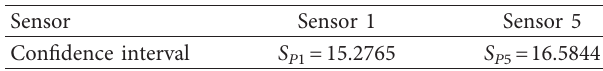
Table 6: The confidence interval of two sensors.